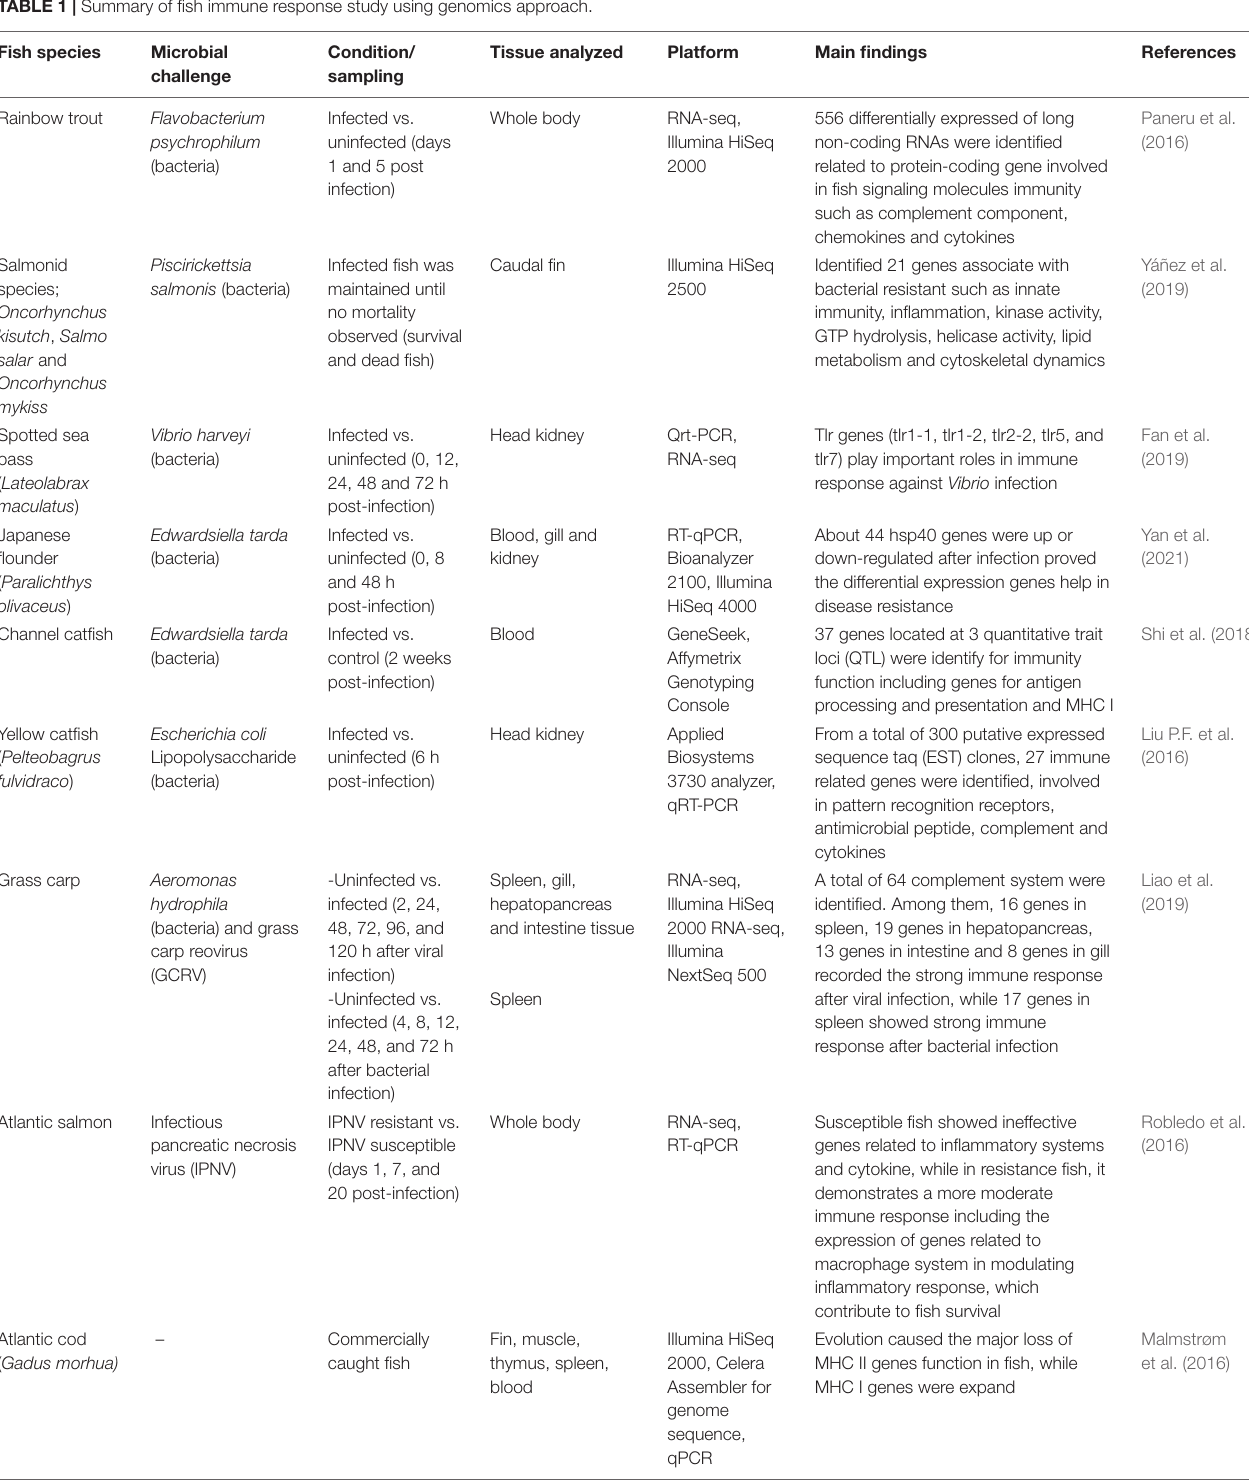
TABLE 1 | Summary of fish immune response study using genomics